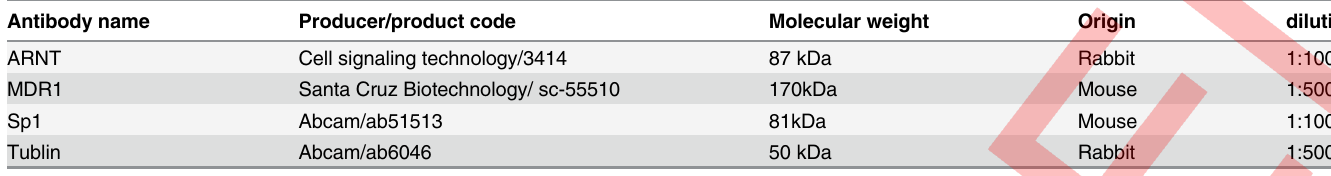
Table 3. Antibodies used in western blotting